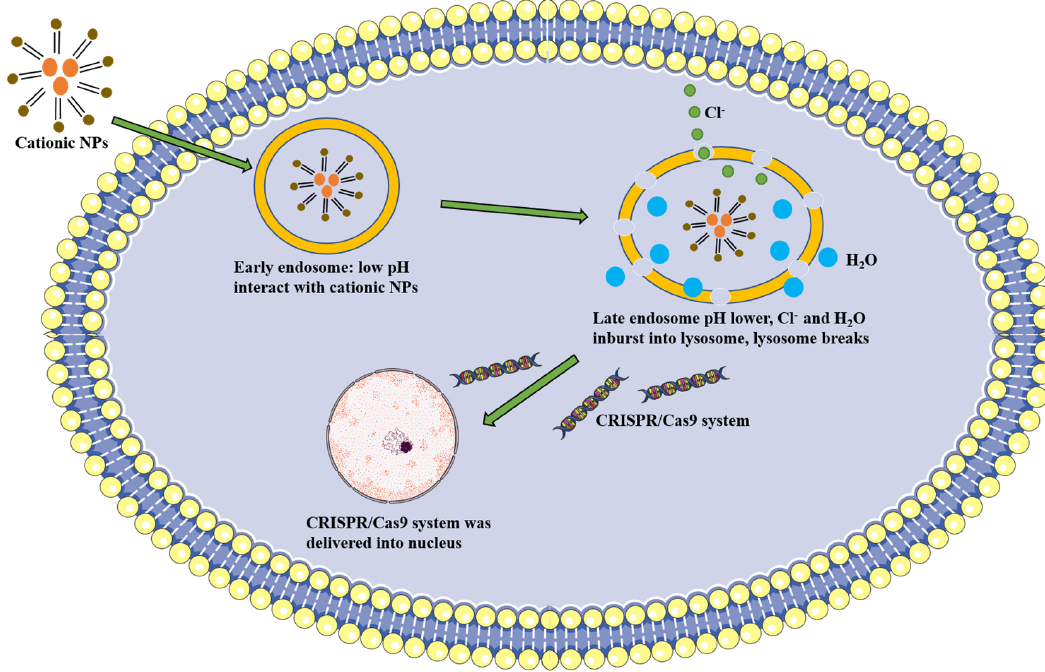
Figure 2. Endosomal escape of cationic NPs by the proton sponge mechanism: the cationic NPs enter early lysosomes through endocytosis, then the drop of pH coupled with the influx of chloride ions and water molecules cause the rupture of late lysosomes, thereby delivering the CRISPR/Cas9 system into the nucleus.